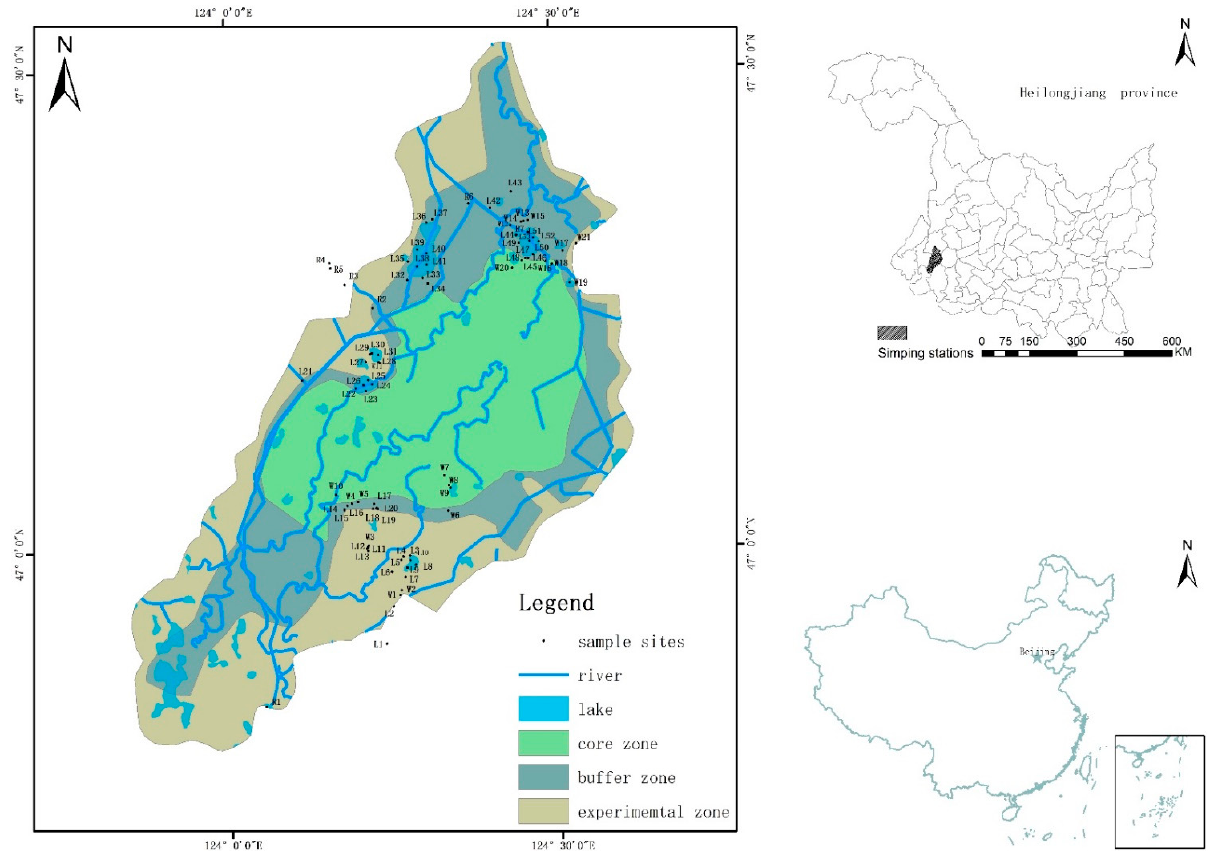
Figure 1. Sample sites within Zhalong National Nature Reserve.